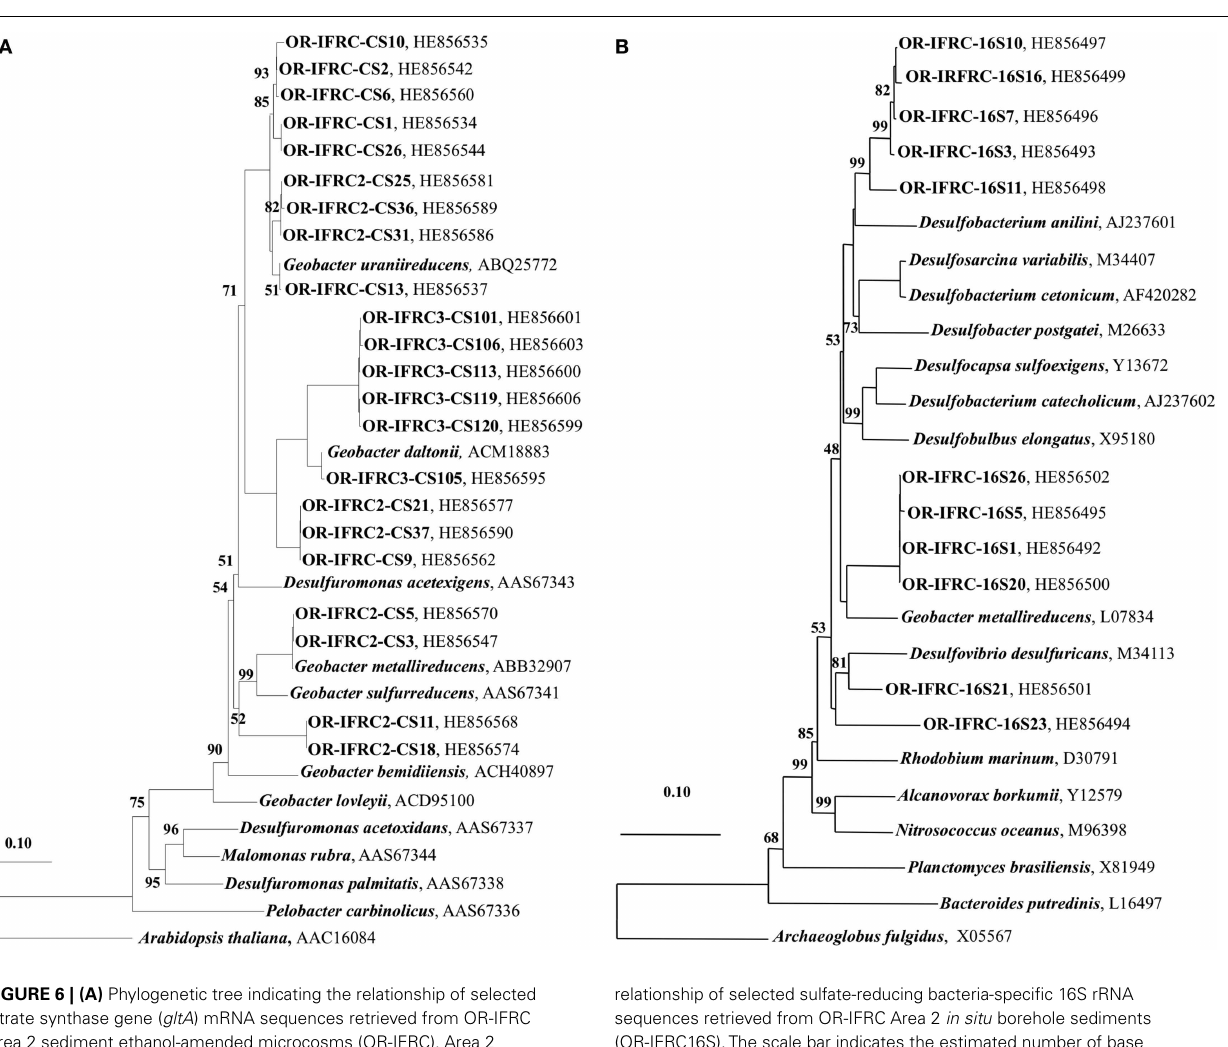
FIGURE 6 | (A) Phylogenetic tree indicating the relationship of selected citrate synthase gene ( gltA ) mRNA sequences retrieved from OR-IFRC Area 2 sediment ethanol-amended microcosms (OR-IFRC), Area 2 in situ borehole sediments (OR-IFRC2), and Area 3 in situ borehole sediments (OR-IFRC3) and (B) Phylogenetic tree indicating the